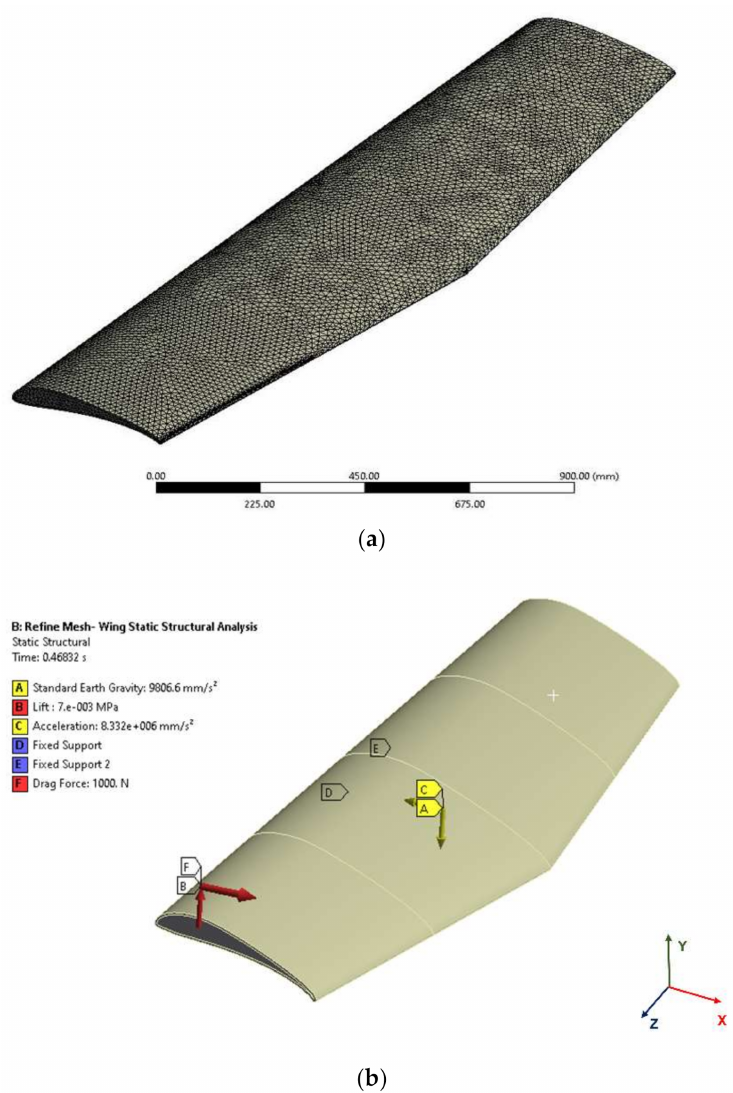
Figure 11. ( a ) The meshing of the wing and ( b ) boundary conditions applied to the wing. Under real operational conditions during takeoff, the RA wing undergoes a recipro- cating motion that is guided by a track through a pitch control mechanism. However, our structural analysis was based on a moving coordinate system that undergoes the same reciprocating motion of the RA wing. As a result, the wing under our analysis appeared to be stationary and was supported by a fixed pitch control mechanism. The boundary conditions included the fixed support (indicated in the setup as the connection to the pitch control mechanism, as shown in Figure 11b). To replicate this boundary condition in the FEA analysis, a portion underneath the wing area was fixed, which is where the pitch control mechanism would be installed. The other boundary conditions included a pressure force ( F lift ), a gravity term ( g ), drag force ( F drag ), and an acceleration term ( x (cid:48)(cid:48) ) to account for the high inertia forces during the reciprocating mode of the wing. The acceleration term may be a function of time and is derived below in the results section. The specification of the acceleration term results in the inertia force condition to be imposed. A pressure force of 7000 N/m 2 acquired from the aerodynamic data was applied as the lift force, while a drag force of 1000 N was imposed based on the minimum ratio of the lift to drag of about